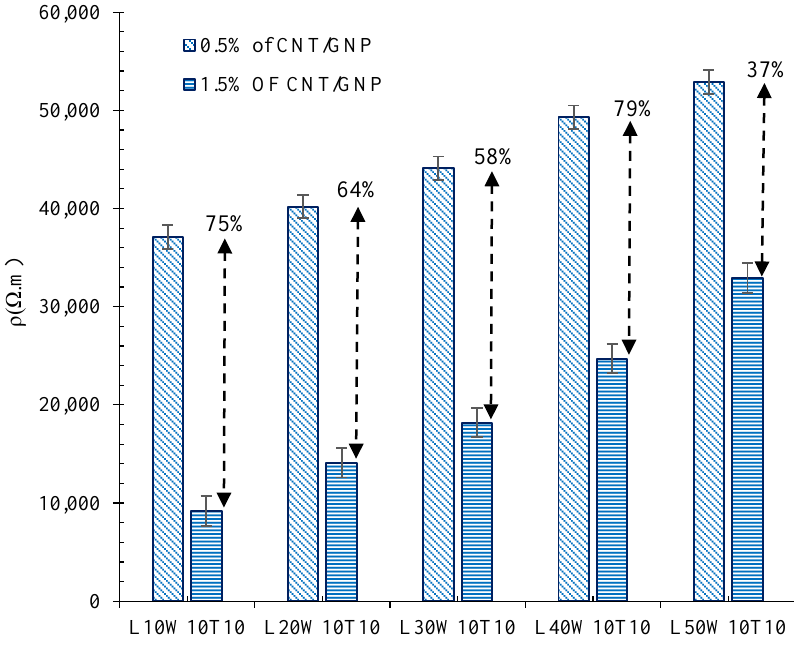
Figure 8. Volumetric electrical resistance of the specimens with different lengths and reinforced by 0.5 and 1.5% CNT/GNP.